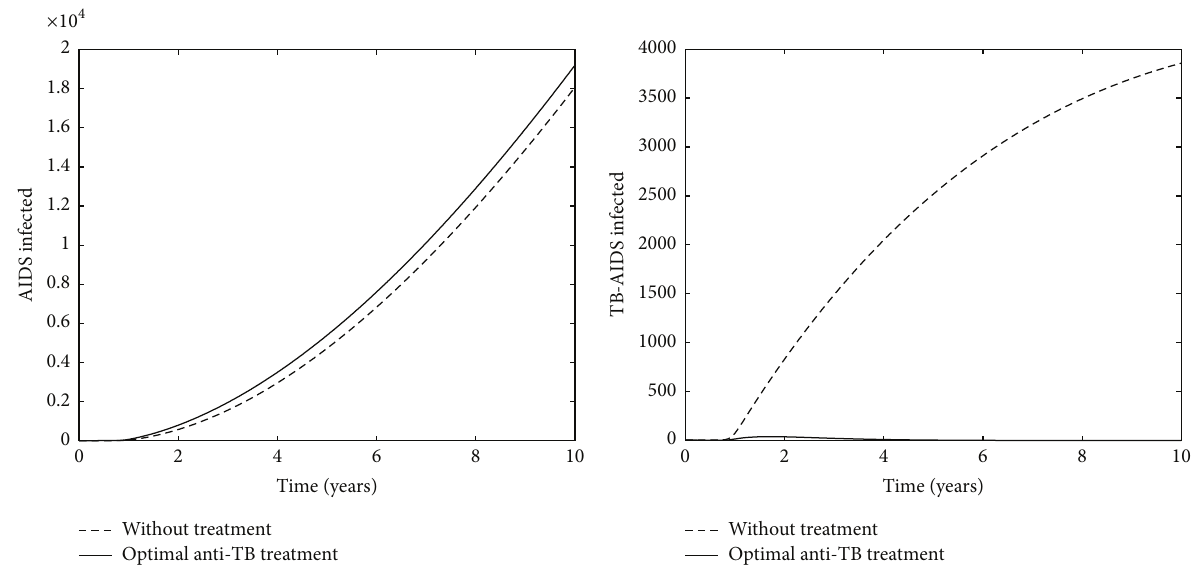
Figure 8: The dynamics of 𝐴 ℎ and 𝐴 ℎ𝑡 using control 𝑢 ∗ 1